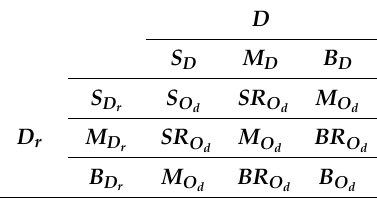
Figure 2. Partitioning results of variables with triangular membership function. ( a – f ) are partitioning results of D , D r , O d , α , α r and O α , respectively. Table 1. Inference rules of fuzzy inference system (FIS d ) on the evolutionary trend of reconstruction trajectory.